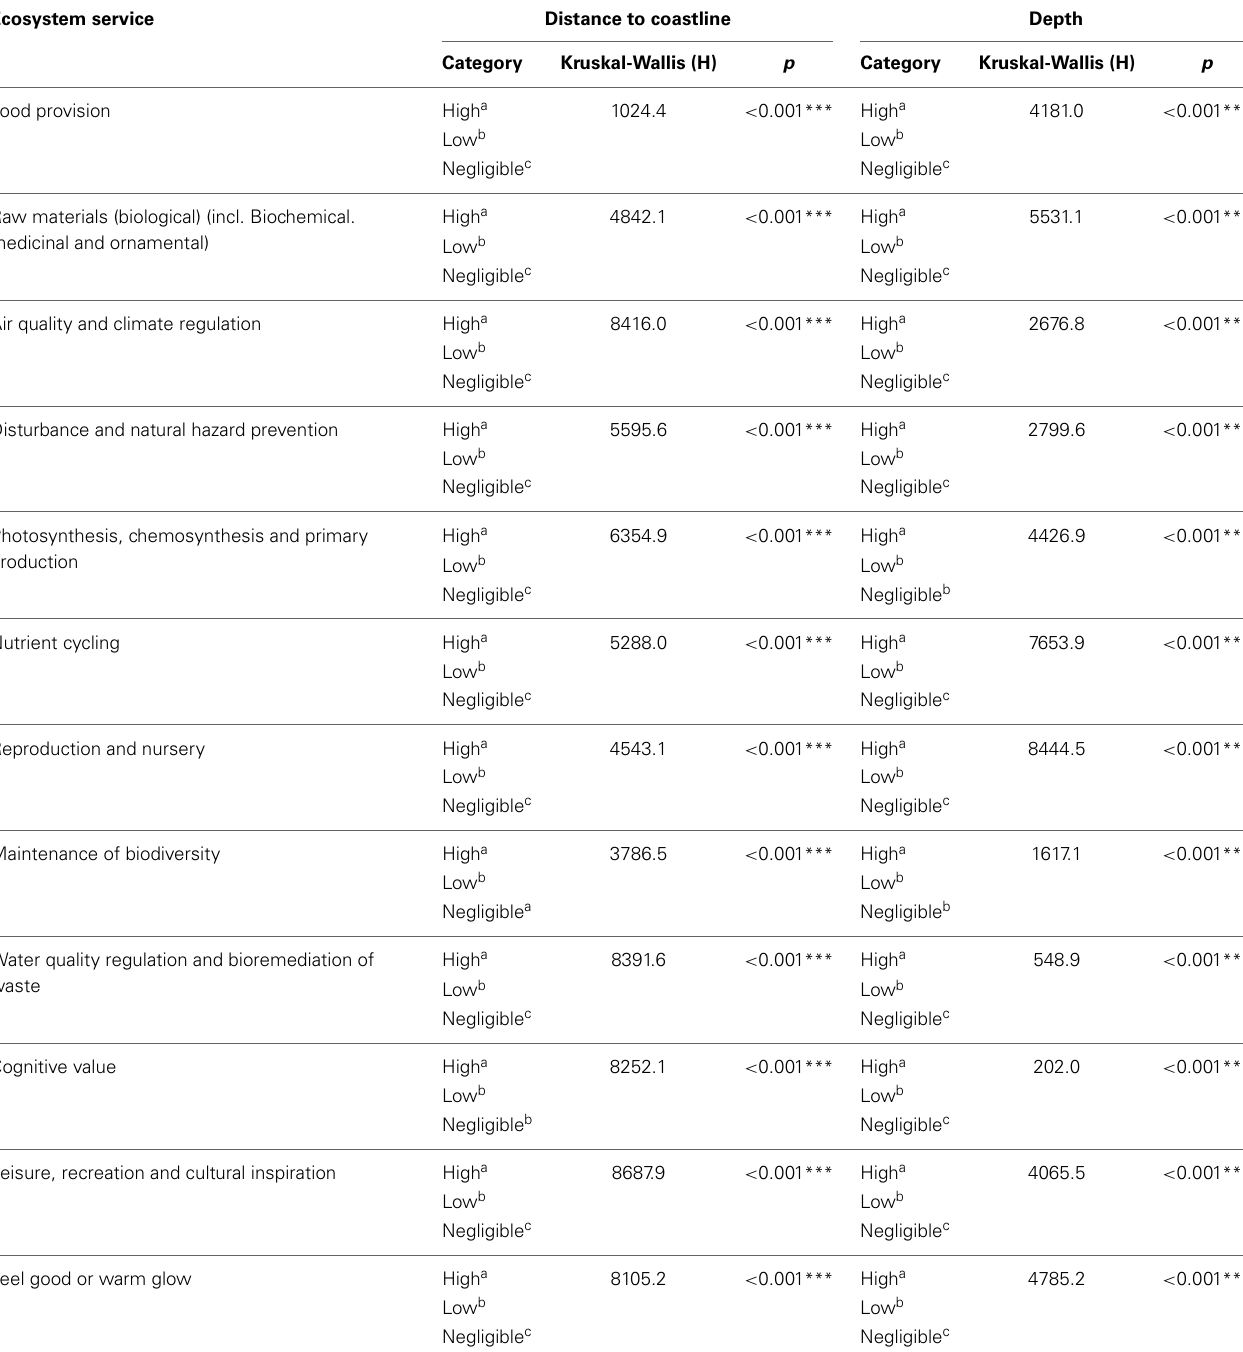
Table 4 | Differences (Kruskal-Wallis test) between ecosystem services categories provided by benthic habitats, according to the distance to coastline, and depth ( N = 55 ,